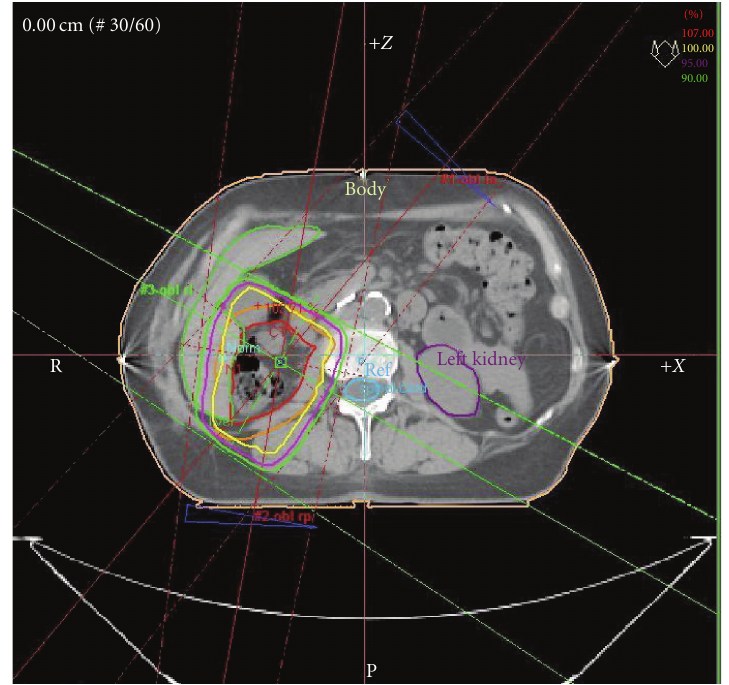
Figure 1: Computer tomography-based treatment plan with a combination of three fields (left anterior oblique, right posterior oblique, and right lateral